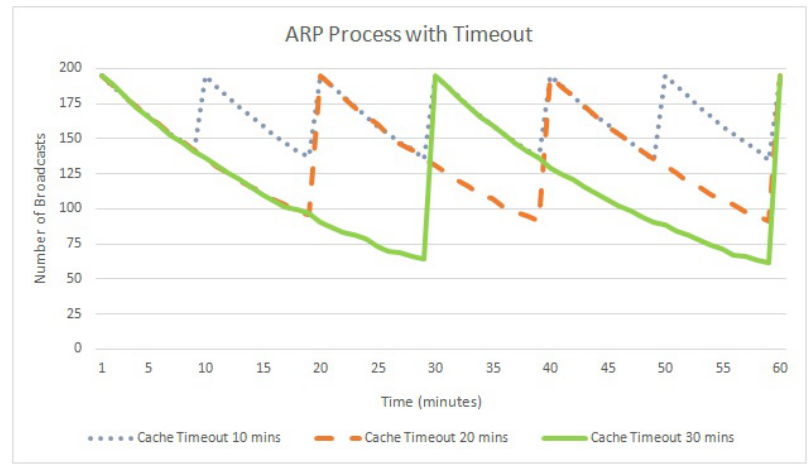
Figure 7. ARP process with time-out = 10, 20 and 30 min (Type 1).